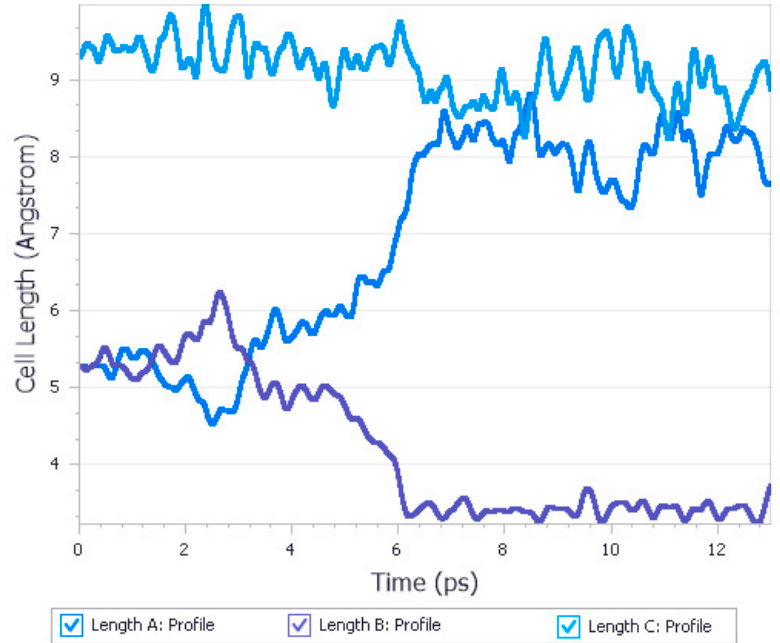
Figure 5. Results of molecular dynamics calculations at 3.10 GPa for urea Form I, unit cell lengths profiles. A phase transition is observed after 6 ps of simulation. The results were found to be in agreement with the experimental data as Form I is metastable and transforms into Form IV at 3.10 GPa. Source: author’s archive, more details [160].